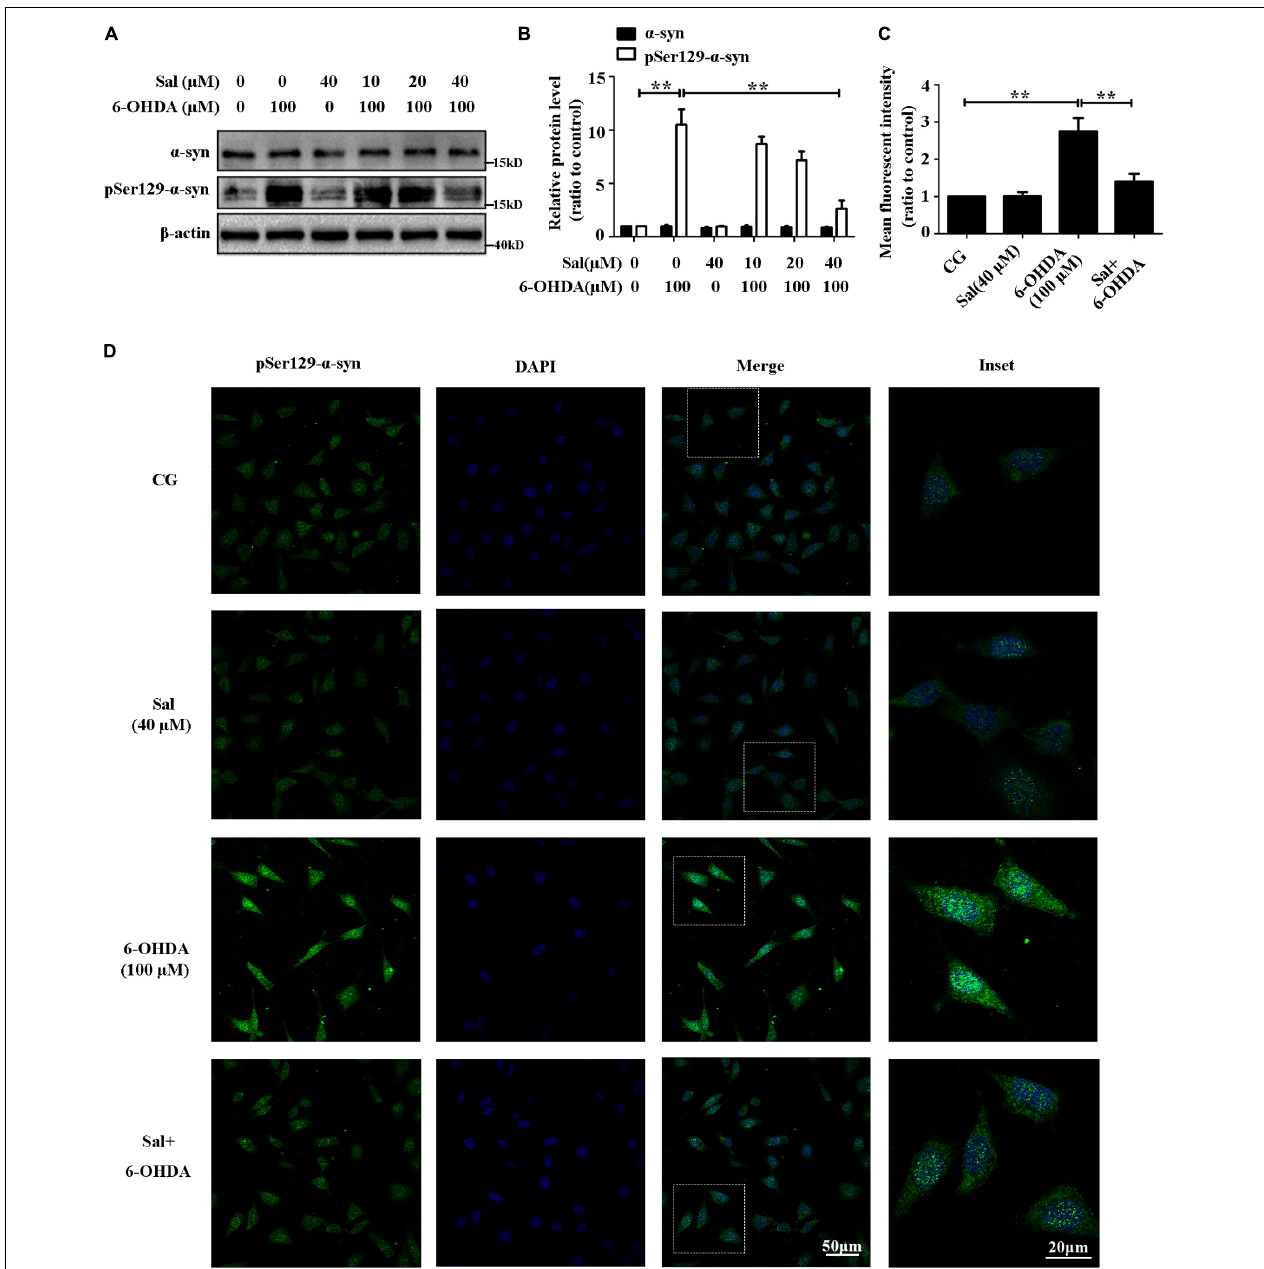
FIGURE 2 | Sal pretreatment decreased pSer129- α -syn protein level against 6-OHDA-induced increase in SH-SY5Y cells. (A) Western blot analysis of α -syn and pSer129- α -syn protein levels in SH-SY5Y cells. Cells were preincubated with Sal (10, 20, and 40 µ M) for 24 h after which 6-OHDA (100 µ M) was added for another 24 h. (B) Graph shows the quantification of α -syn and pSer129- α -syn protein levels. (C and D) Immunofluorescence analysis of pSer129- α -syn in SH-SY5Y cells. Cells were preincubated with Sal (40 µ M) for 24 h after which 6-OHDA (100 µ M) was added for an additional 24 h. (C) Quantitative analysis of the pSer129- α -syn immunofluorescence intensity. (D) The pSer129- α -syn protein level were analyzed using immunofluorescence (green: pSer129- α -syn; blue: DAPI; the insets represent the boxed areas), bar: 50 µ m. Data are shown as the mean ± SEM. Statistical significance was analyzed by one-way analysis of variance (ANOVA). A two-tailed Student’s t -test was performed for comparisons between two groups. Each experiment was repeated three times independently. ∗ P < 0.05; ∗∗ P < 0.01, ns: no significance.